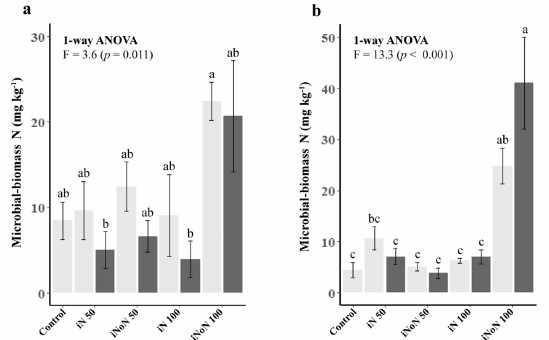
Figure 5. Microbial-biomass N (mg kg − 1 ) from rhizosphere potting mix of macadamia seedlings after ( a ) 12 weeks and ( b ) 28 weeks growing under different fertilizer-N sources (iN, iNoN) without or with PGPR inoculation. Light grey bars represent treatments not inoculated with PGPR; dark grey bars display treatments inoculated with PGPR. Shown are mean microbial-biomass N (±SE, n = 4). Different letters above means indicate significant differences among treatments (one-way ANOVA and Tukey’s post hoc tests, p < 0.05).